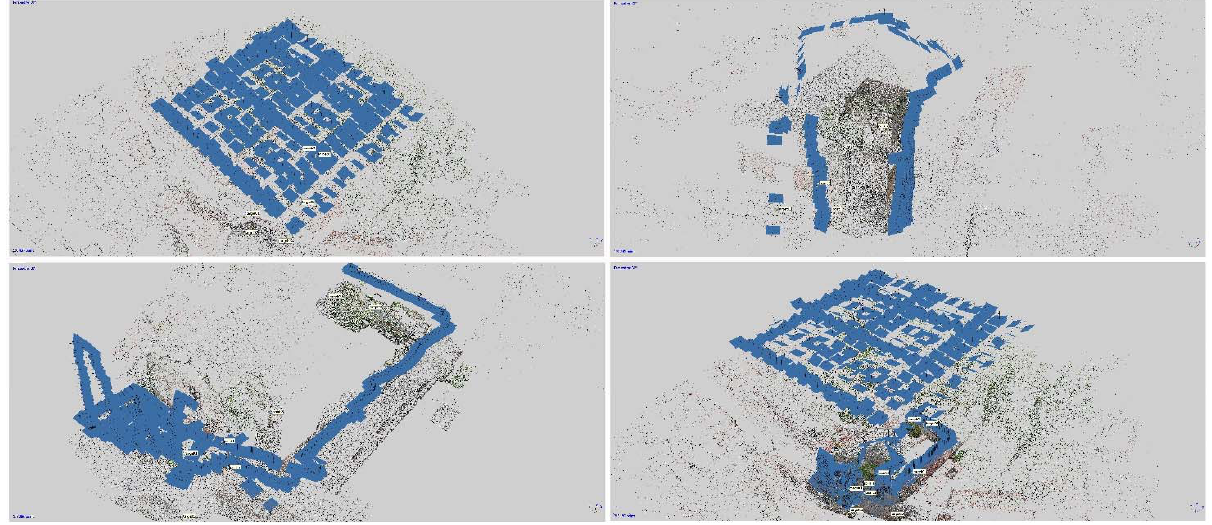
Figure 8. Photographic datasets processing: the area surrounding the church, bell tower, external prospects.